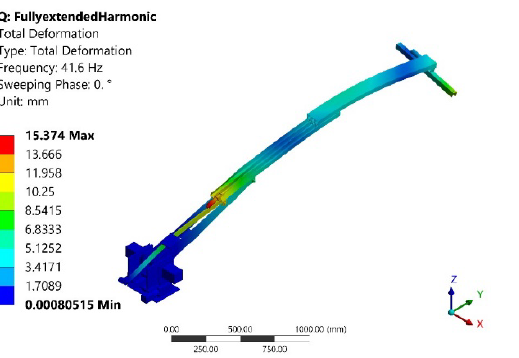
Figure 18. Total deformation (in mm) of the fully-extended configuration structure resulting from the harmonic analysis at the 6th natural frequency (41.6 Hz).